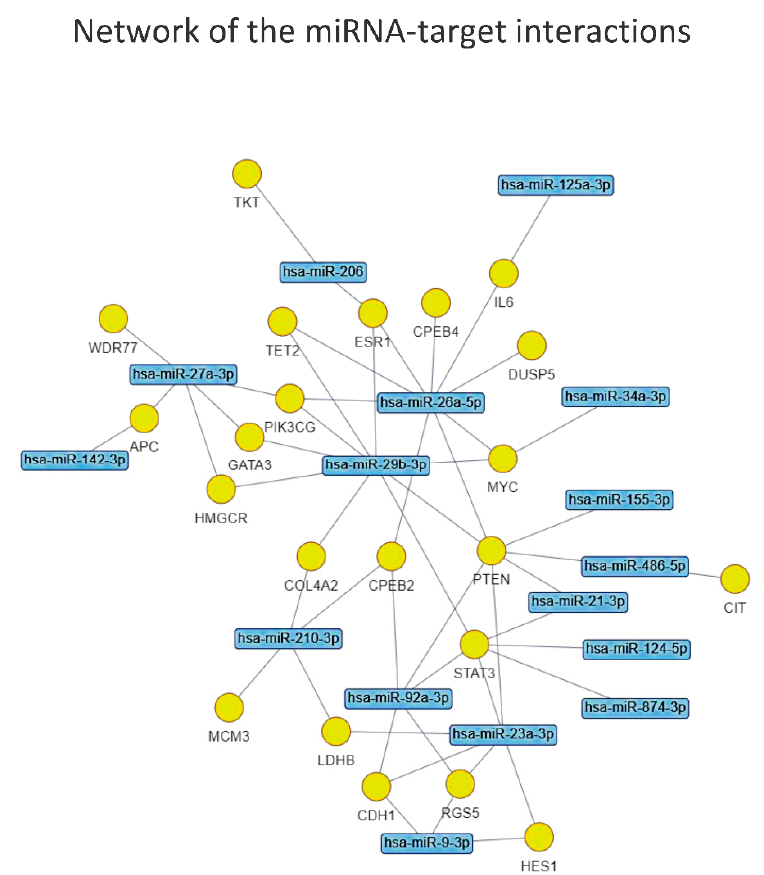
Figure 6. Graphical representation of the network of miRNA-target interactions identified by the enrichment analysis.